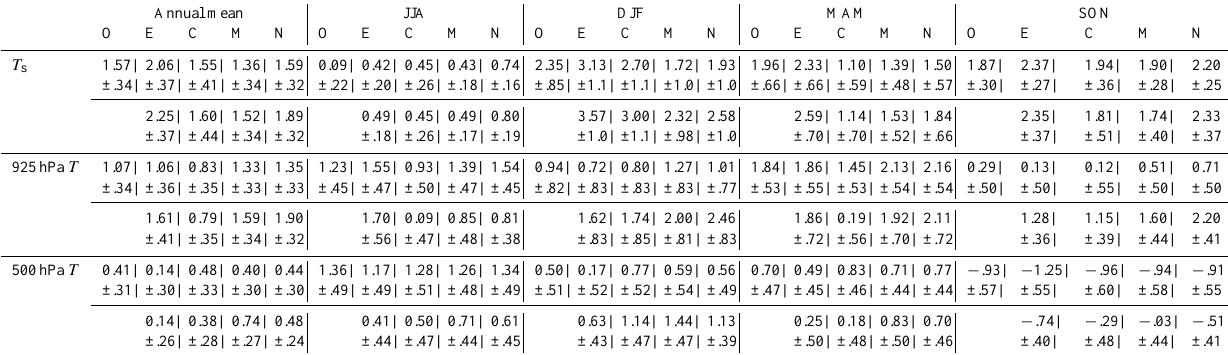
Table 4. 70–90 ◦ N average temperature trend from 1998 to 2011 in units of temperature change (in K) over the 14yr. In the case of CFSR, the trend is from 1998 to 2009 in units of temperature change over the